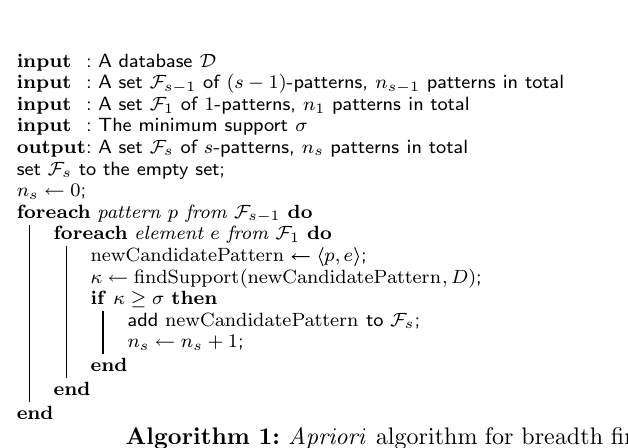
Algorithm 1: Apriori algorithm for breadth first search